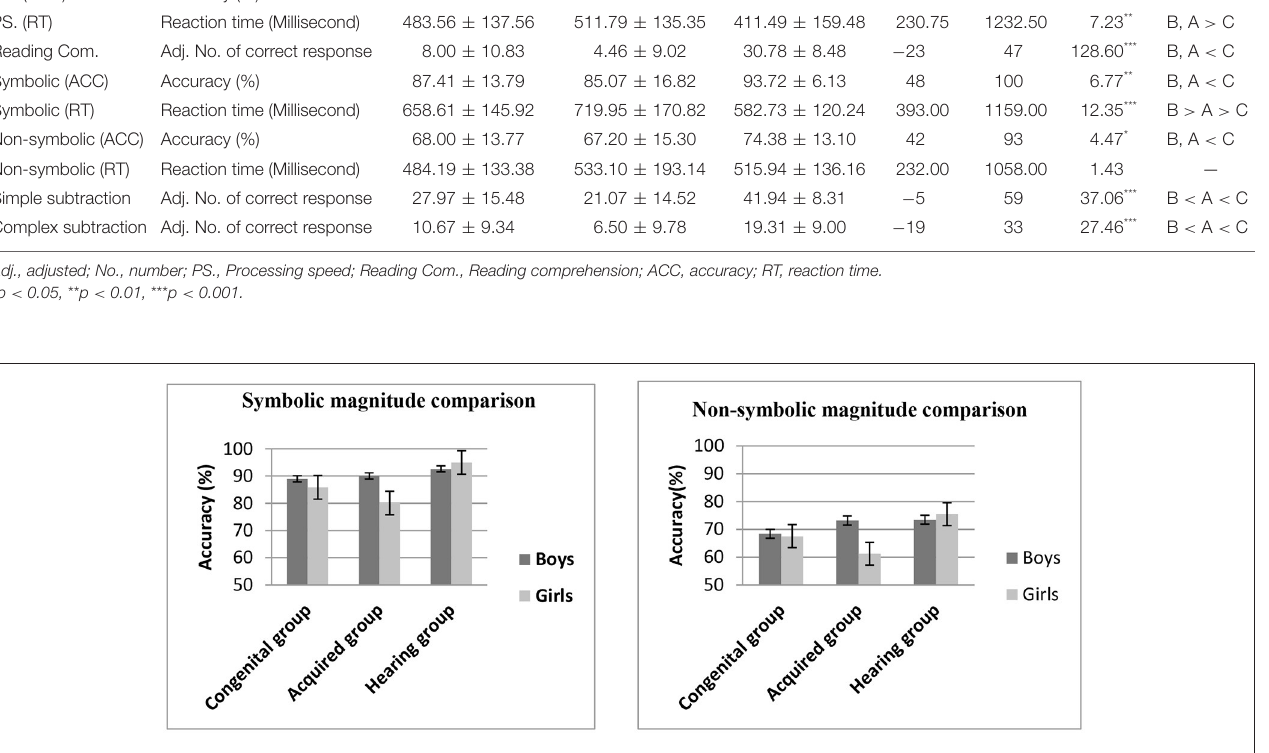
FIGURE 1 | Mean accuracy (%) on the numerical magnitude comparison task (symbolic and non-symbolic) across groups.